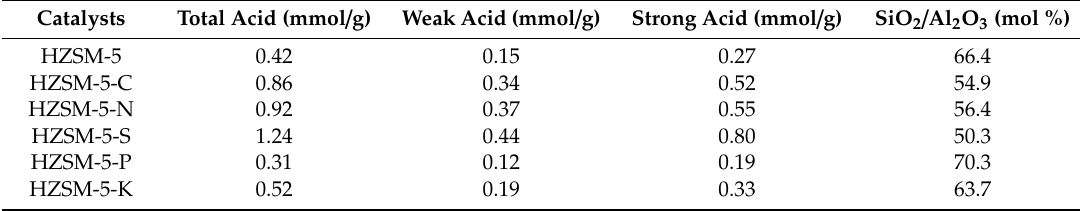
Table 3. Distribution of acid sites and SiO 2 / Al 2 O 3 ratio of the catalyst.